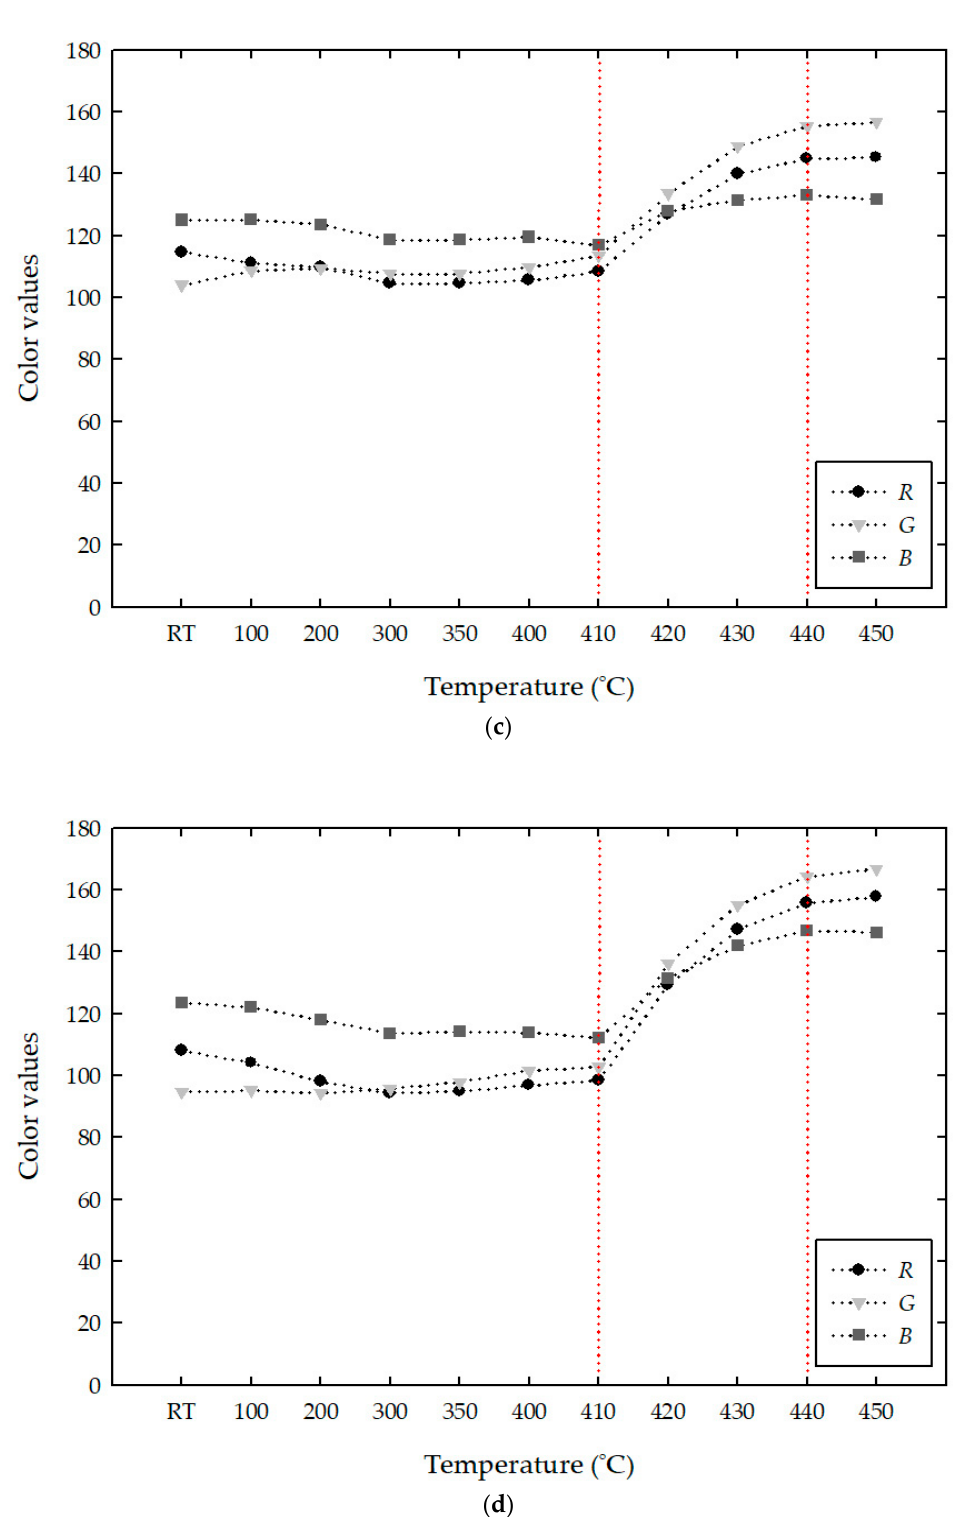
Figure 9. Changes in the RGB values of the white cement (WC) and MV mixed samples with increasing temperature: ( a ) WC; ( b ) WC + 1% MV; ( c ) WC + 3% MV; and ( d ) WC + 5% MV.